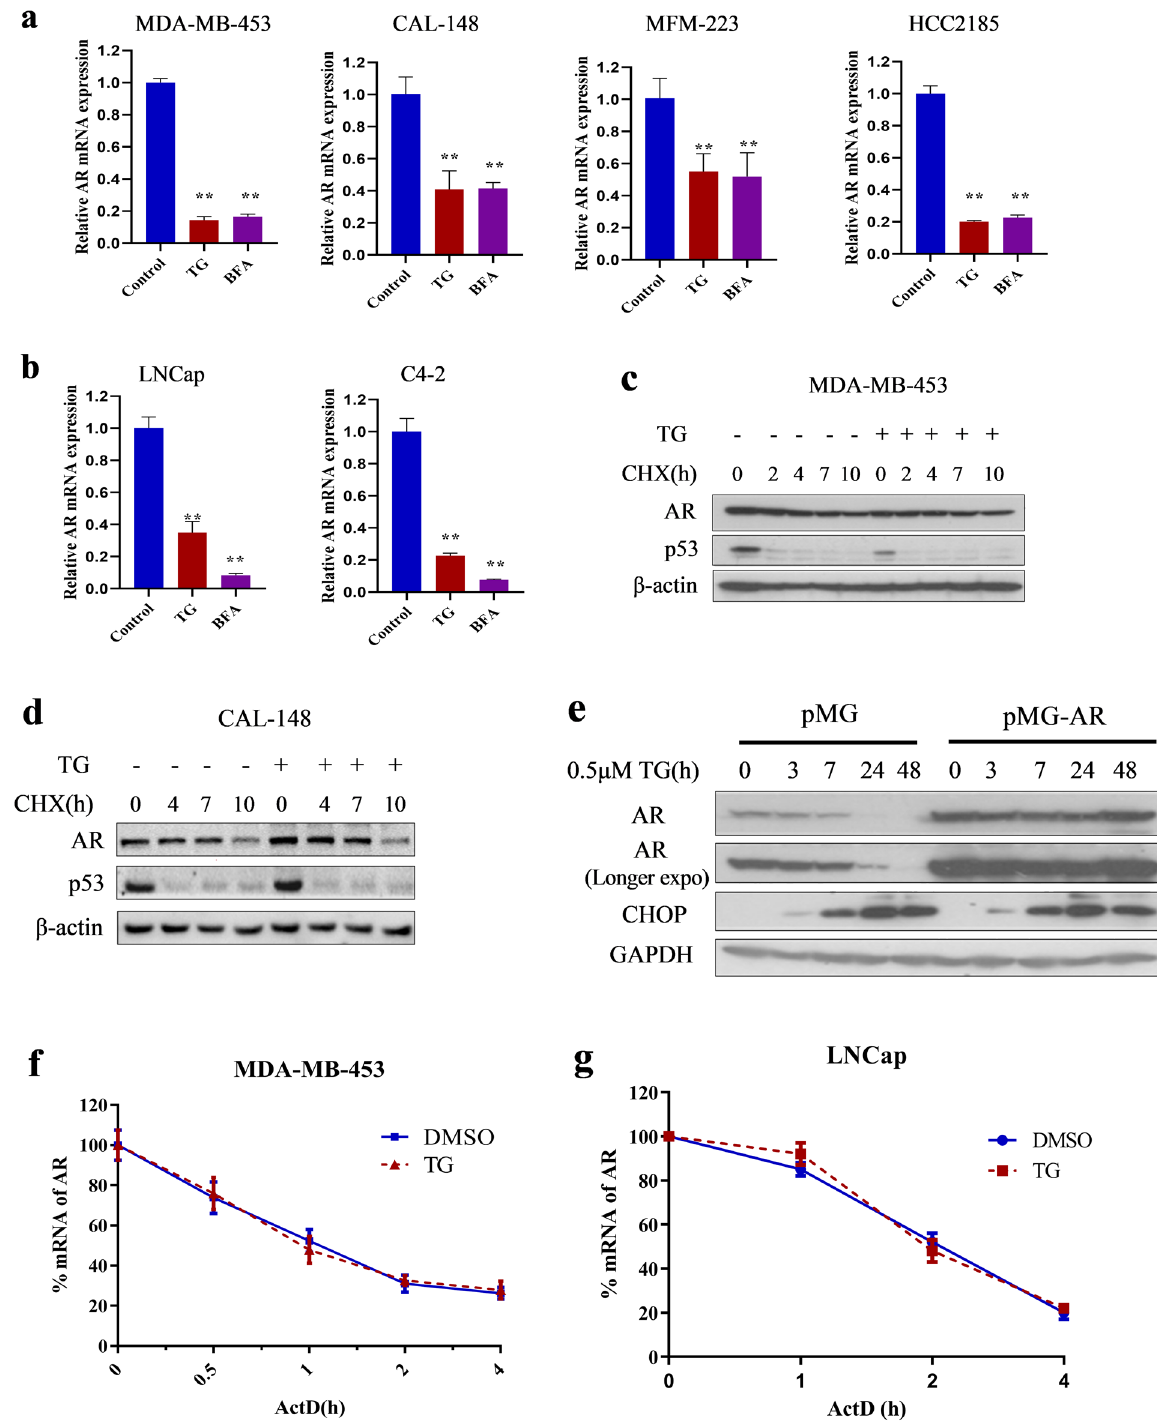
Fig. 2 ER-stress down-regulated AR mRNA expression through transcriptional level in LAR TNBC and PCa cells. a , b Breast cancer cell lines MDA-MB-453, CAL-148, MFM-223 and HCC2185 ( a ), and prostate cancer cell lines LNCap and C4-2 ( b ) were treated with 1 μ M TG or 5 μ g/mL BFA for 24 h. Then cells were collected for quantitative RT-PCR assay. The relative expression of AR was normalized to β -actin and expressed as mean ± SD ( n = 3). Student ’ s t -test, ** p < 0.01 vs . control. c , d MDA-MB-453 ( c ) and CAL-148 ( d ) cells were pretreated with 100 μ g/mL CHX for 1 h and then treated with or without 1 μ M TG during the indicated times. After TG treatment, cells were collected for western blotting assays. e LNCap cells were transfected with empty vector (pMG) or overexpression of AR vector (pMG-AR) and then treated with or without TG during the indicated times. Cells were collected for western blotting assays. f , g MDA-MB-453 ( f ) and LNCap ( g ) cells were pretreated with 1 μ g/mL ActD for 0.5 h and then treated with or without 1 μ M TG during the indicated time. Then, cells were collected for quantitative RT-PCR assays ( n = 3). Thapsigargin, cycloheximide, actinomycin D is abbreviated as TG, CHX, and ActD, respectively.